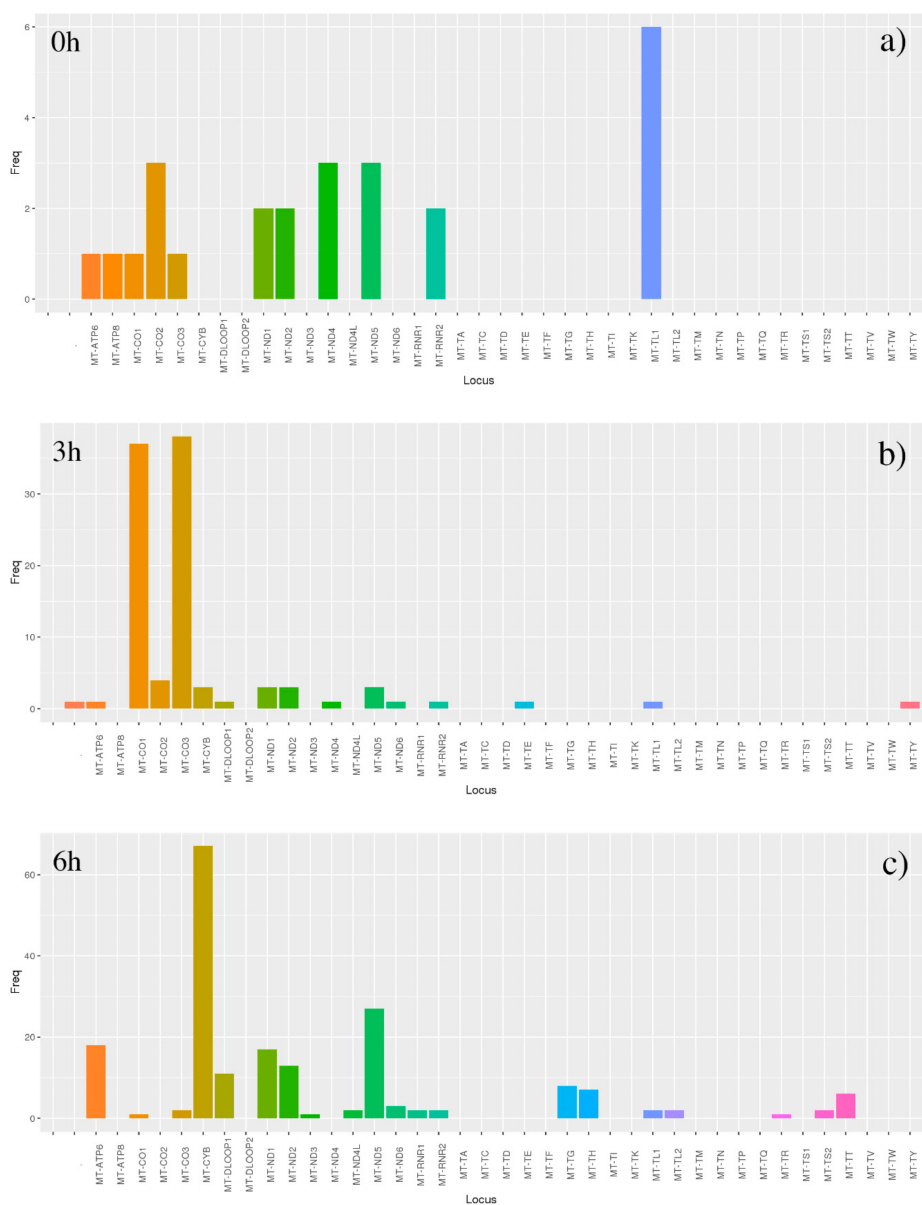
Figure 8. Results of heteroplasmic analyses by mtDNA-Server. The tool mtDNA-Server found heteroplasmic significant results in all samples, evaluated in all time-related conditions ( a = 0 h, b = 3 h, c = 6 h), reaching the highest scores in 6 h treated sample. The highest peaks were reached by MT-CO1 and MT-CO3 loci in 3 h treated ( b ), and by MT-CYB locus in 6 h treatment ( c